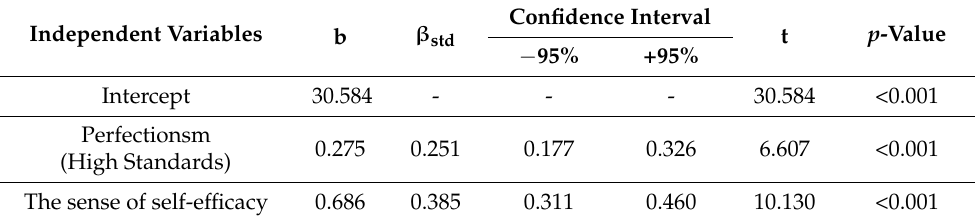
Table 4. Mediation